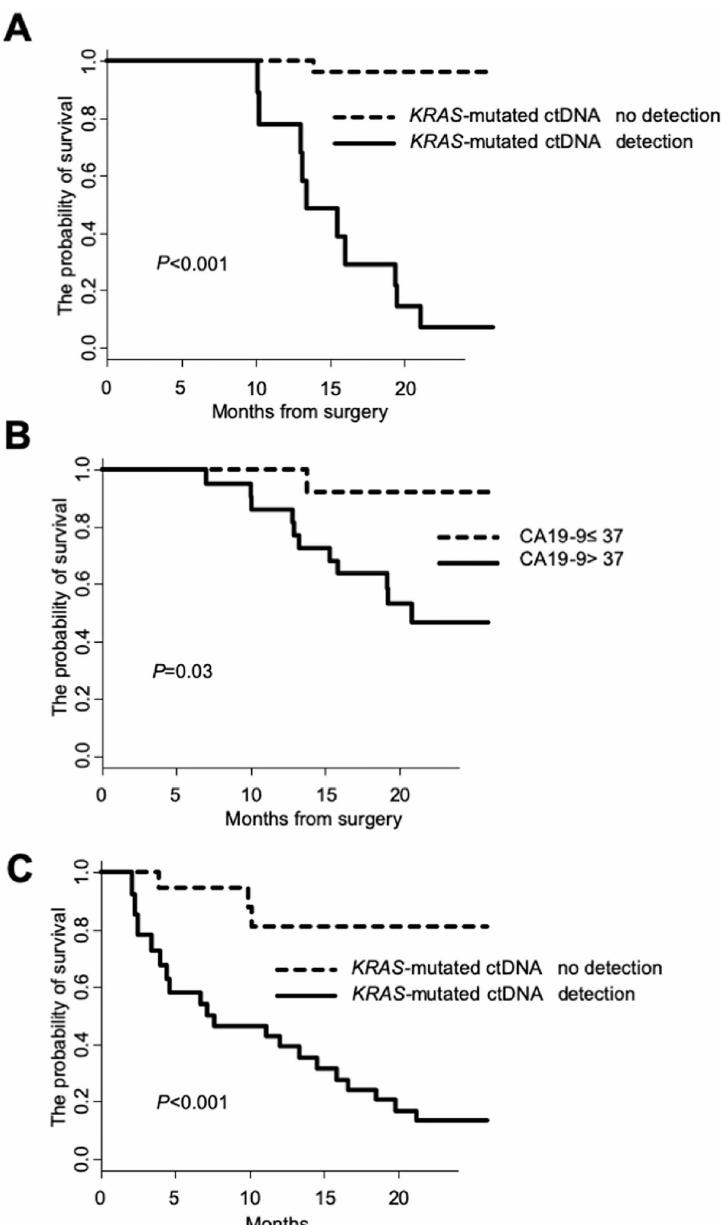
Fig 3. Outcome according to KRAS- mutated ctDNA and CA19-9 in longitudinal evaluations. (A) Simon–Makuch plot for the effect of emergence of KRAS- mutated ctDNA on overall survival (OS) in patients who underwent surgery, illustrated by a landmark at 8 months, the median time point for the detection of KRAS- mutated ctDNA ( P < 0.001). (B) Simon–Makuch plot for the effect of CA19-9 level on OS in patients who underwent surgery, illustrated by a landmark at 4 months, the median time point for CA19-9 level increasing to > 37 U/mL ( P = 0.03). (C) Simon– Makuch plot for the effect of emergence of KRAS- mutated ctDNA on OS in patients who did not undergo surgery, illustrated by a landmark at 2 months, the median time point for the detection of KRAS- mutated ctDNA ( P < 0.001). X- axes in Fig 3A and 3B indicate the months from surgery, X-axis in Fig 3C indicates the months from the initial evaluation in this study, whereas Y-axes indicate the probability of